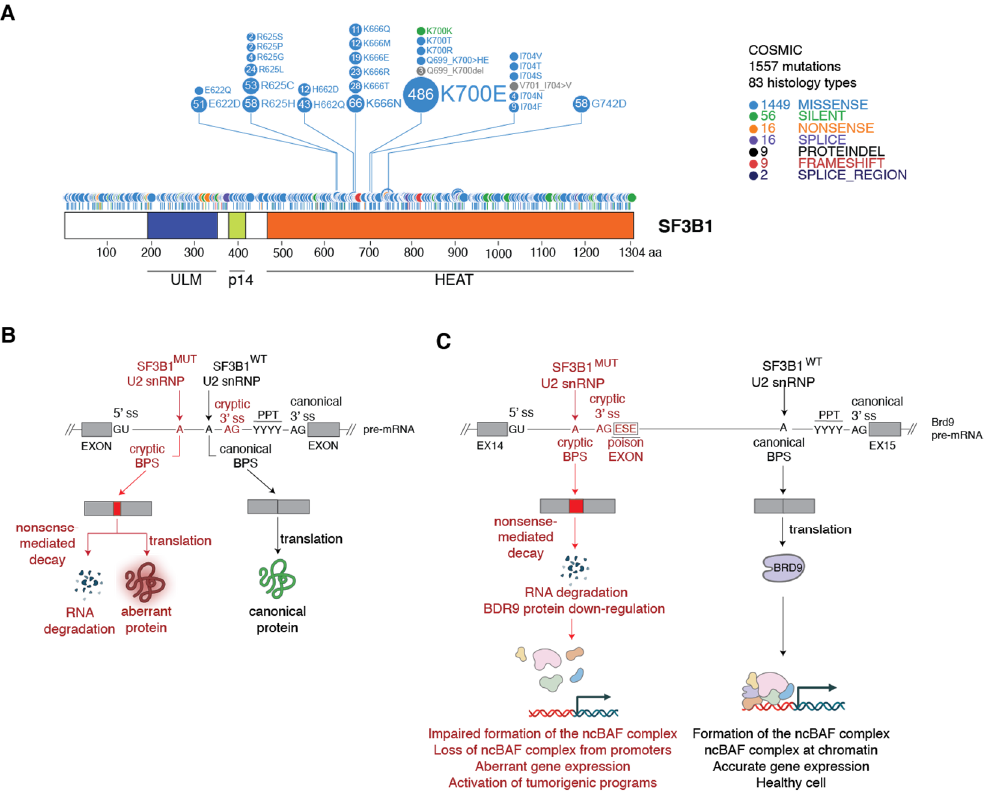
Figure 3. Mutant SF3B1 binds cryptic BPS and promotes the use of cryptic 3 ′ splice sites. ( A ) Schematic representation of the SF3B1 protein domains and its mutation profile. SF3B1 domains are indicated: U2AF-homology ligand motif (ULM), p14 binding domain (p14), and HEAT-repeat domain (HEAT). The mutation profile was obtained from the COSMIC database (https://cancer.sanger.ac.uk/cosmic, accessed on 25 October 2021) and visualized using ProteinPaint (https://pecan.stjude.cloud/proteinpaint, accessed on 25 October 2021). The number of samples harboring each mutation is indicated inside each circle and their relative abundance is represented by the disc size. ( B ) Sequence requirements for cryptic BPS usage by mutant SF3B1. A schematic exon-intron-exon region is shown together with the characteristic sequence features present in the splicing events altered by SF3B1 MUT : the 5 ′ splice site (5 ′ ss), the canonical and cryptic 3 ′ splice sites (3 ′ ss), the canonical and cryptic BPS, and the PPT. Red indicates the SF3B1 mutant, the adenine at the cryptic BPS, and the AG dinucleotide at the 3 ′ cryptic splice site. ( C ) Mutant SF3B1 promotes the inclusion of a poison exon in the BRD9 transcript. Schematic representation of the BRD9 pre-mRNA containing the exon 14-intron-exon 15 region. The required splicing sequences are indicated as in (B). ESE, exon splicing enhancer. Poison exon inclusion targets the BRD9 transcript to NMD, promoting BRD9 protein down-regulation and impaired formation of the ncBAF complex.